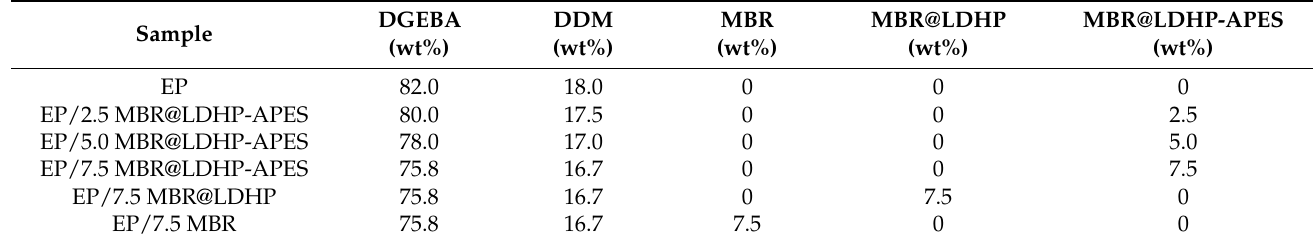
Table 2. Pure EP preparations and their